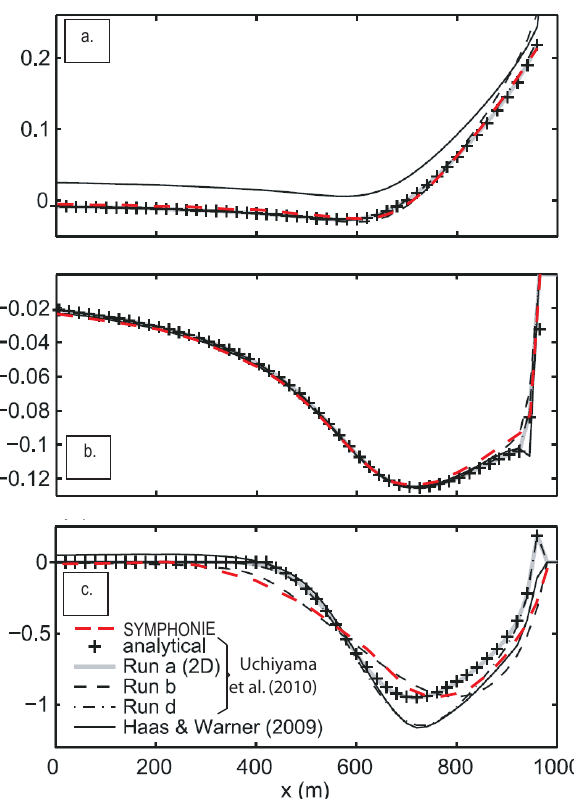
Fig. 2. Vertical sections of quasi-Eulerian cross-shore (top) and longshore (middle) velocities and of the vertical eddy viscosity K z (bottom) in